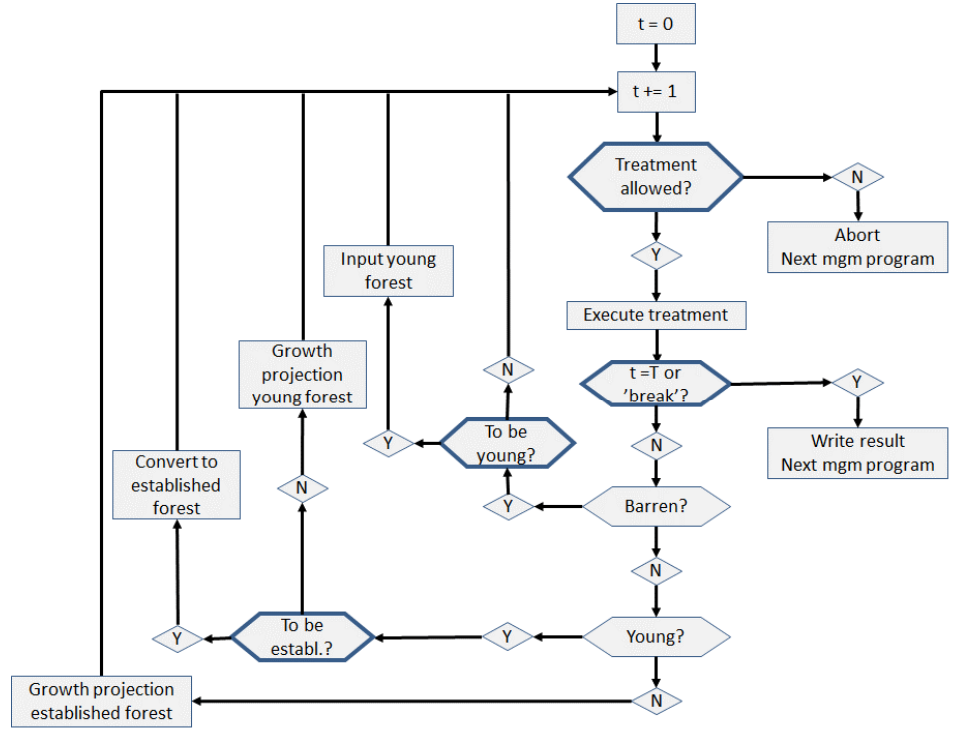
Figure 1. The projection of one management programme. Controls entirely in the hands of the user are marked with thick borders of decision points. A stand can be in one of three states: barren, young, or established. The update of the state of the forest depends on whether the ground is barren (there are no trees), if it is young forest (the stand does contain trees but no basal area), or if it is established (there are trees with basal area). The workflow for projecting the stand one period is as follows: 1.